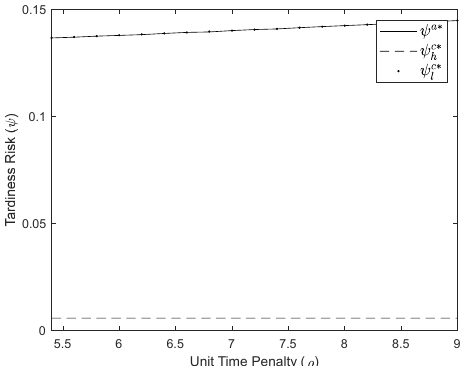
Fig. 10. The tardiness risk in centralized system and asymmetric